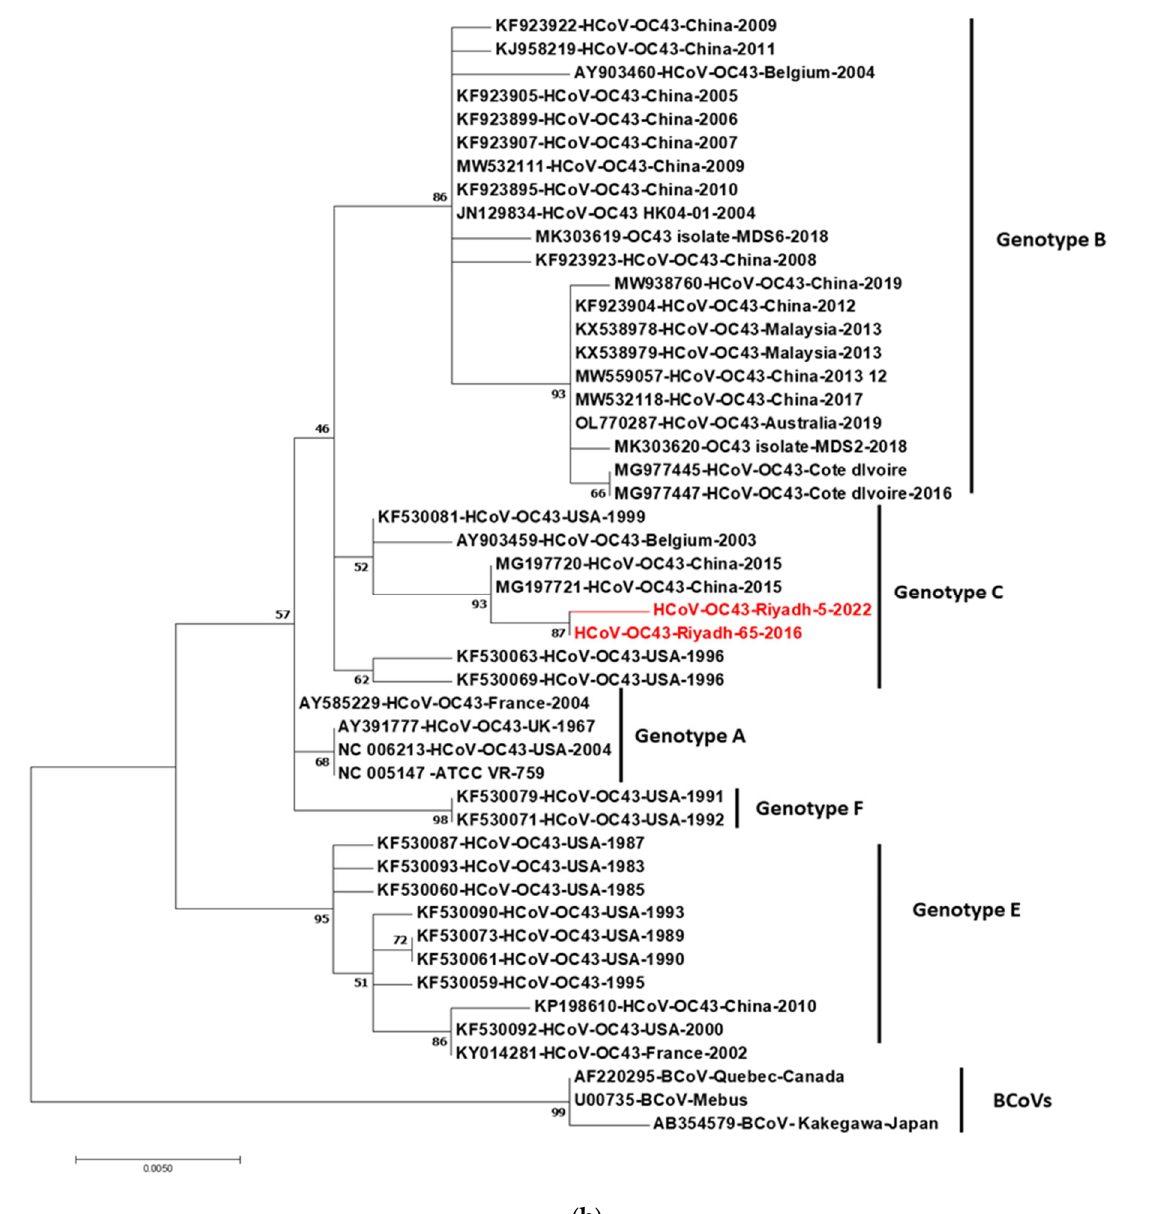
Figure 2. Phylogenetic analysis tress based on (a) 1052 nucleotides of the S gene (subunit 1) and ( b ) 837 nt of the N gene. Multiple sequence alignment was performed using Clustal W, and the phylogram was generated by the MEGA 7 program using the maximum likelihood method. Strains of bovine coronaviruses were used to root the trees. Strains in red fonts refer to Saudi stains identified and sequenced in the currents study. Only bootstrap values exceeding 50% are displayed. Saudi strains of the seasons 2015/2016 and 2021/2022 are presented in red font. Genotypes are indicated at the periphery of the phylogram.